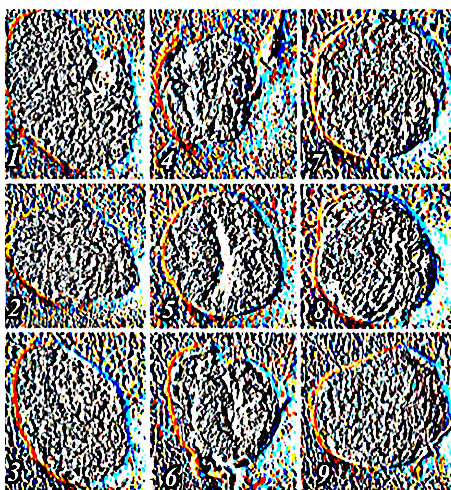
Figure 5. Processing the image of potato tubers in Figure 2 using the Sobel filter: ( 1 – 3 ) dry rotted tubers; ( 4 – 6 ) tubers affected by rodents; ( 7 – 9 ) healthy tubers.